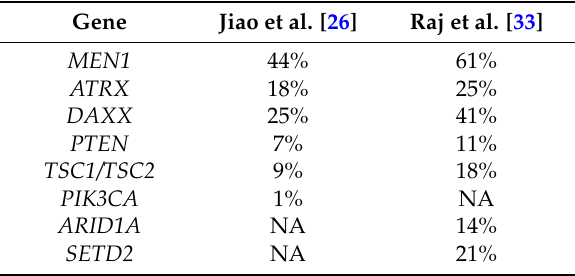
Table 2. Prevalence of common gene mutations for well-differentiated pNENs.